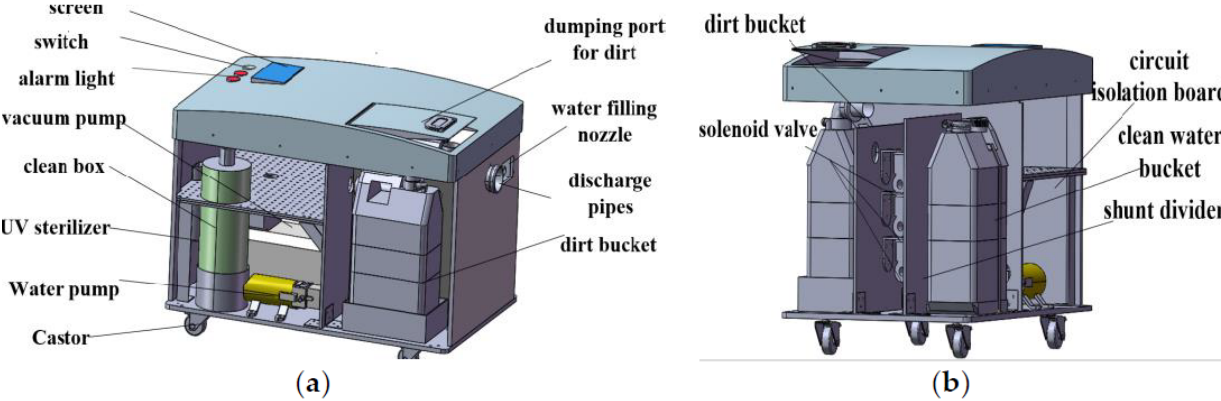
Figure 4. Mechanical structure of main engine. ( a ) Side view; ( b ) Front side view.